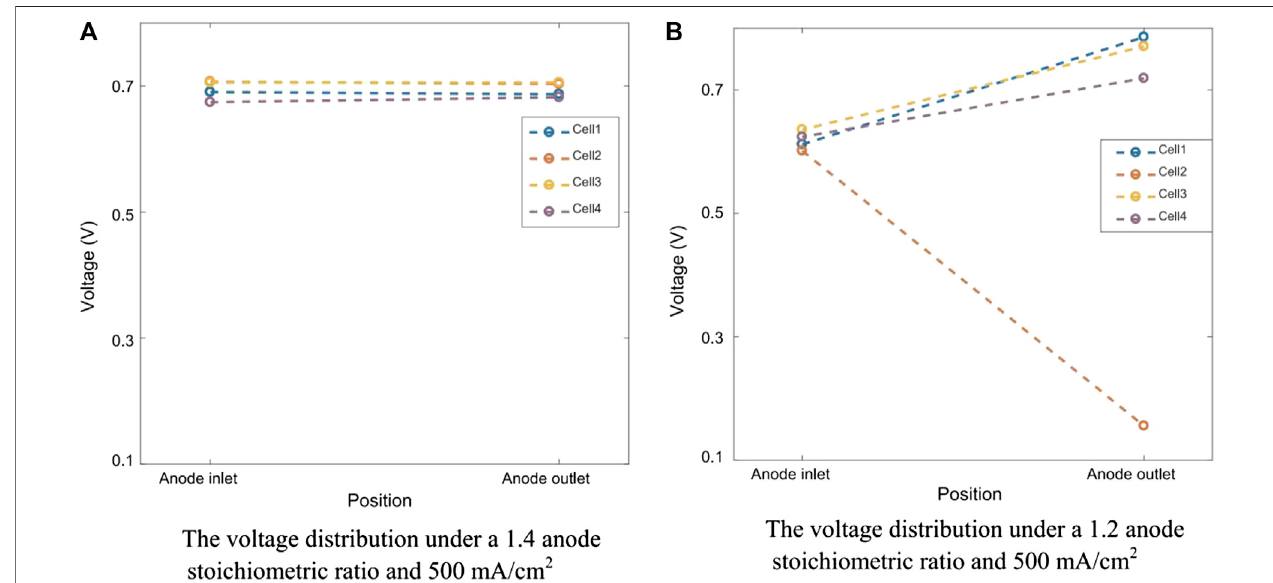
FIGURE 3 | Voltage difference between the two ends of the cells. Reproduced with permission (Hu et al., 2018). Copyright 2018, Elsevier.